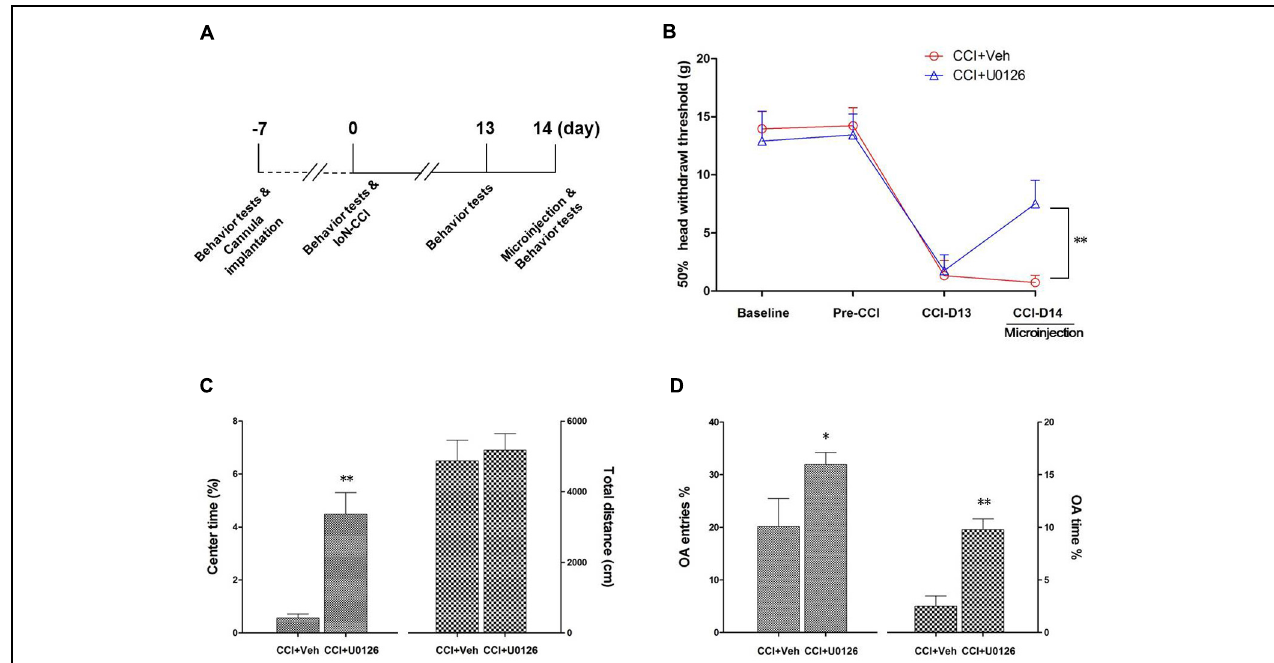
FIGURE 6 | Intra-IC U0126 microinjection improved nociceptive behaviors as well as pain-related negative emotions. (A) Experimental schedule. The behavioral tests, cannula implantation, microinjection, and IoN-CCI surgery were conducted as indicated in the schedule. (B) The 50% HWT were significantly improved by bilateral intra-IC U0126 microinjection following IoN-CCI ( ∗∗ P < 0.01, CCI + U0126 compared with CCI + vehicle group, n = 4 rats/group). (C,D) Pain-related negative emotions such as anxiety/depression-like behaviors, as revealed by the OF (C) and EPM (D) tests, were significantly improved after intra-IC U0126 microinjection on day 14 after IoN-CCI ( ∗ P < 0.05; ∗∗ P < 0.01, CCI + U0126 compared with CCI + vehicle group, n = 4